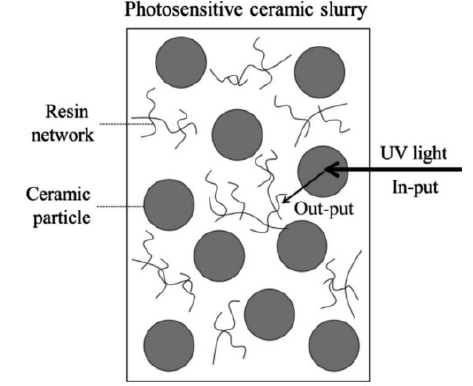
Fig. 29 Schematic drawing of the curing mechanism of SiC-resin slurry. Reproduced with permission from Ref. [84], © The American Ceramic Society